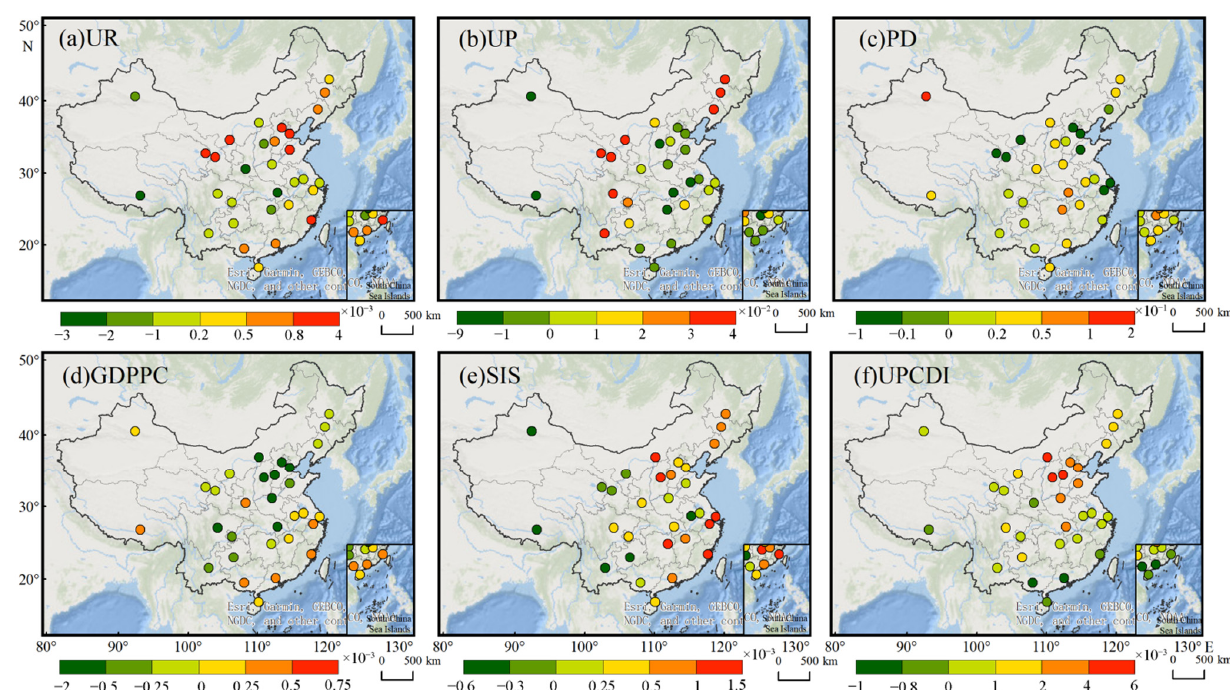
Figure 8. The estimated coefficients of GTWR in 31 provincial capital cities.